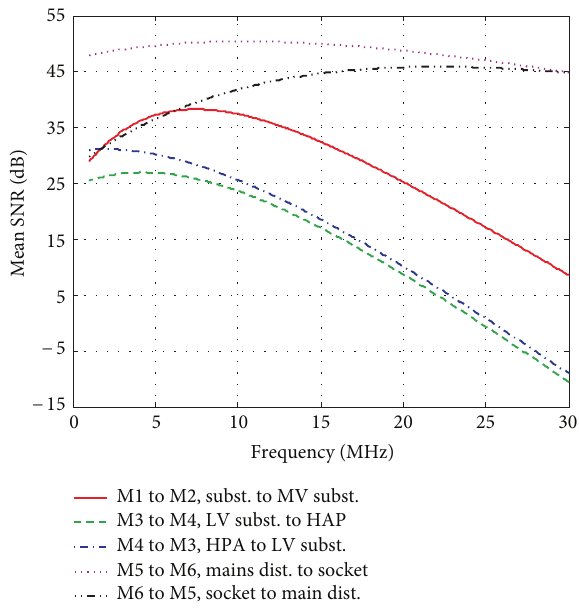
Figure 4: Mean SNR based on –50 dBm/Hz injected PSD, as well as mean channel gain and mean noise power spectral density